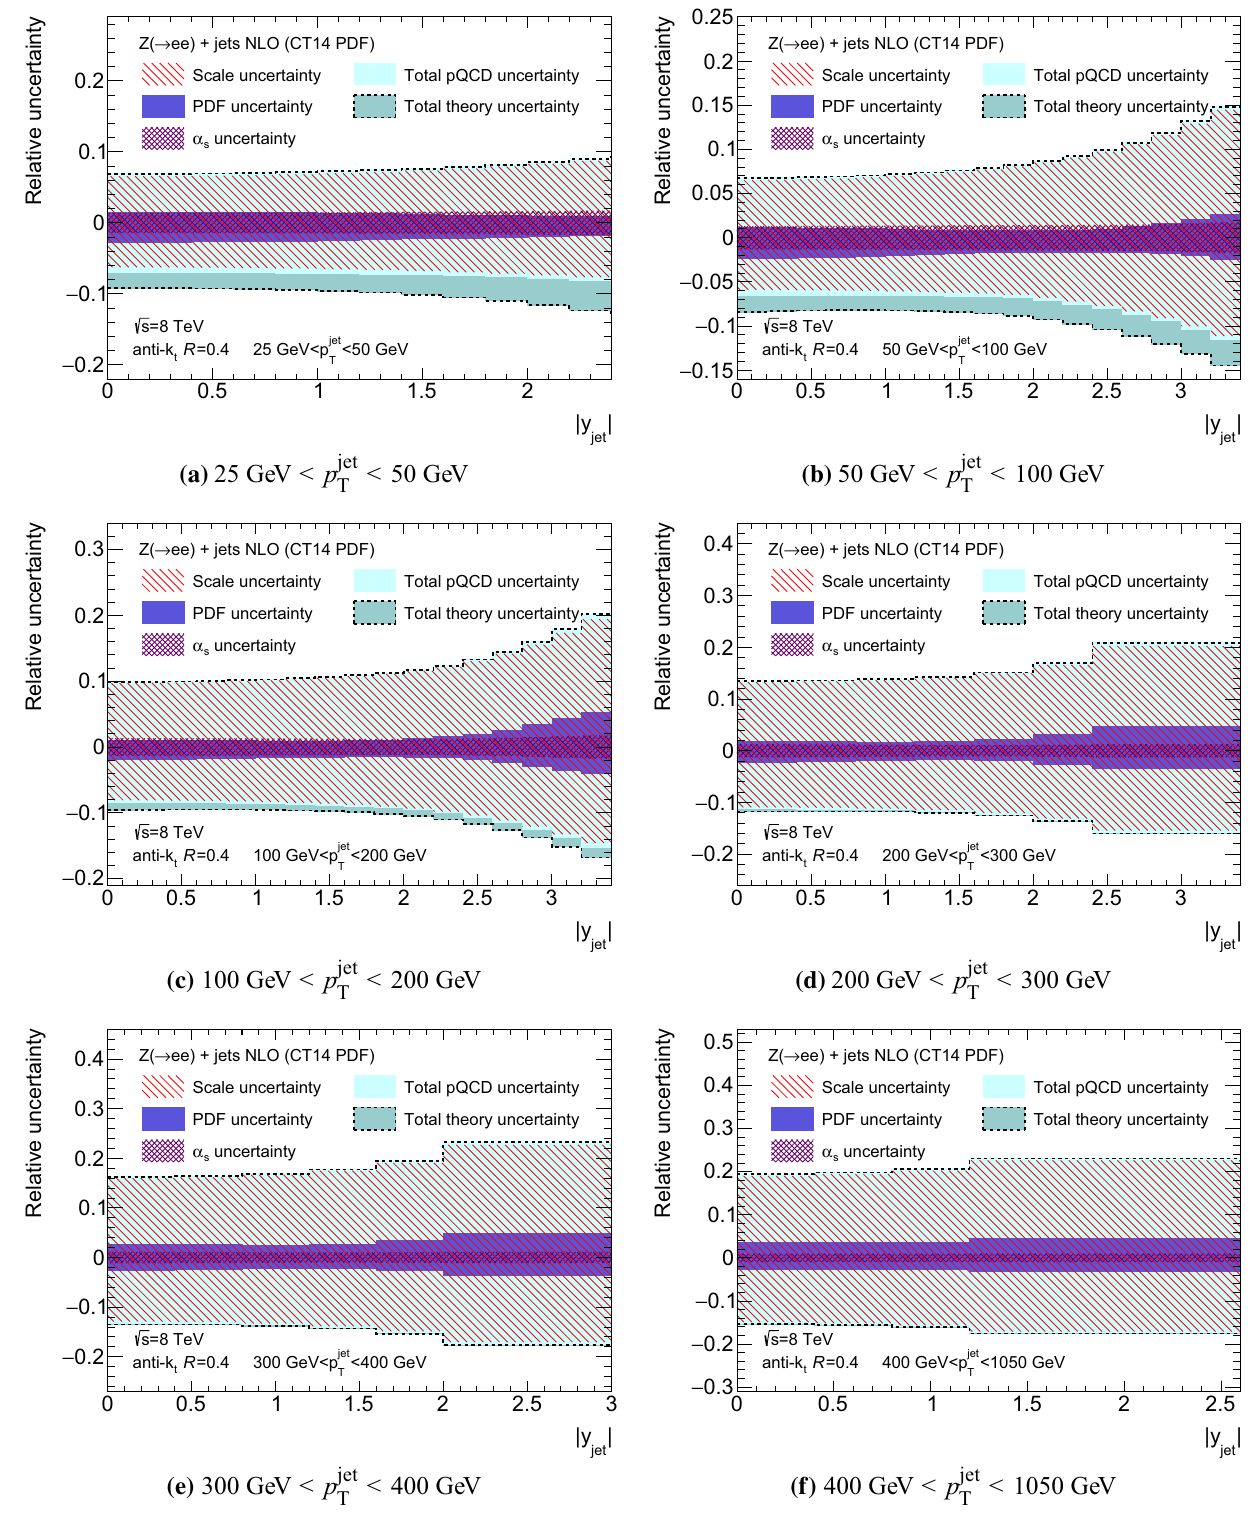
Fig. 5 The uncertainties in NLO pQCD predictions as a function of | y | in p jet bins. Total pQCD uncertainty is the sum in quadrature of jet T the PDF, scale and α S uncertainties. Total theory uncertainty is the sum